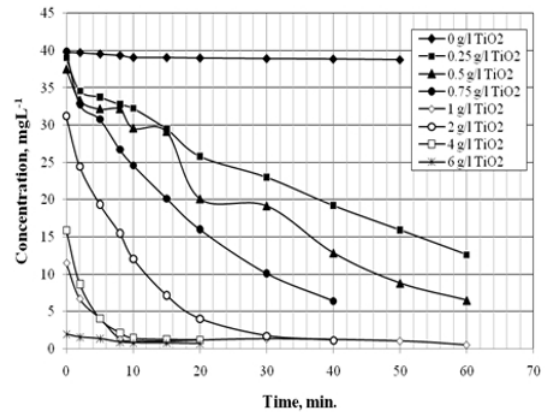
Figure 7. The influence of H photodegradation